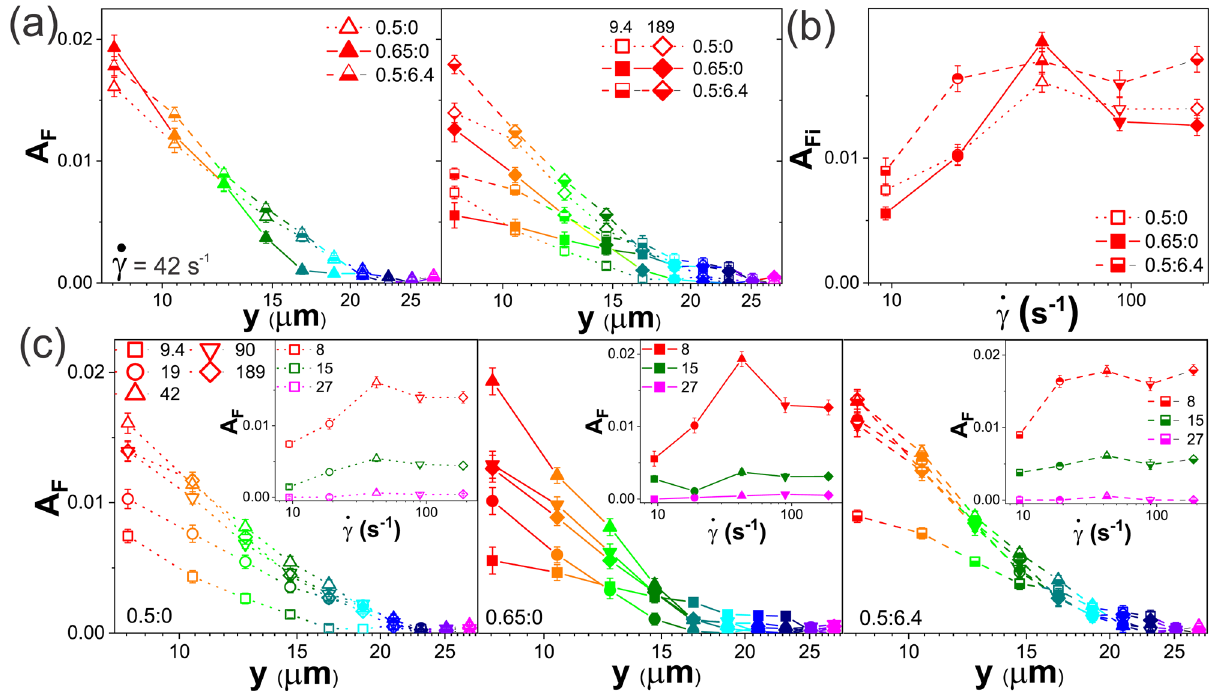
Fig. 2 | Local shearing induces strain alignment of DNA with a non-monotonic rate dependence. a Alignment factor A F versus distance y (increasing from warm to cool colors)fora _ γ = 42s − 1 strain(left)and ~4.5-foldslower( _ γ = 9.4s − 1 , squares) and faster ( _ γ = 189s − 1 , diamonds) strains (right) applied to solutions with c D : c T =0.5:0 (open symbols), 0.65:0 (closed symbols), and 0.5:6.4 (half- fi